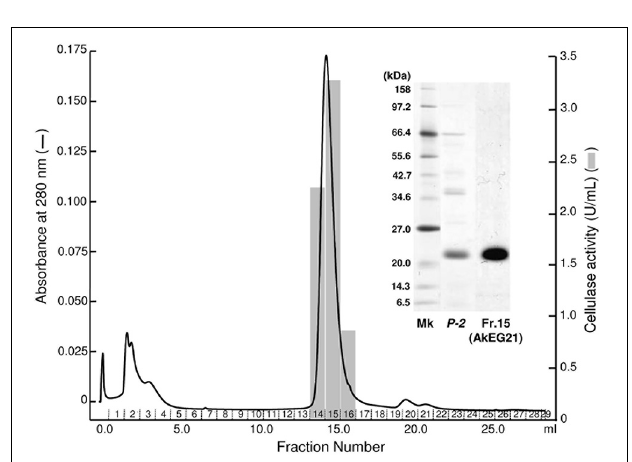
FIGURE 2 | Purification of AkEG21 by Superdex 200 gel filtration. The P-2 fraction obtained in the TOYOPEARL CM-650M column chromatography was subjected to gel filtration through Superdex 200 10/300 GL. Fractions 14–16 were pooled as the purified AkEG21. SDS-PAGE for cellulase preparations from A. kurodai is shown in the inset. Mk, marker protein; P-2 , the sample after TOYOPEARL CM-650M chromatography; Fr. 15 , purified